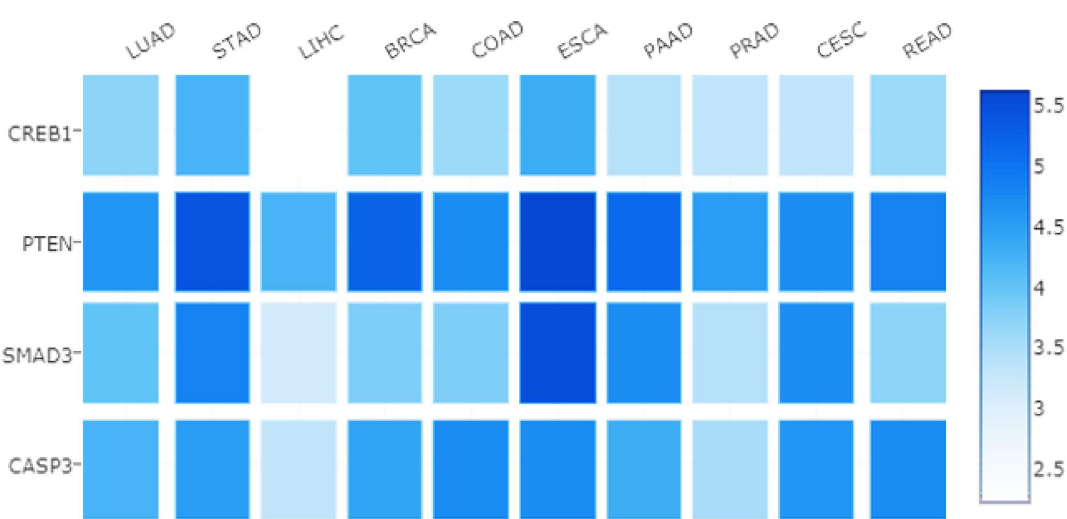
Figure 6. A heatmap of candidate genes in the ten most fatal types of cancer. The GEPIA 2 server has provided the expression levels of candidate genes in the most fatal types of cancer. LUAD (Lung adenocarcinoma), STAD (Stomach adenocarcinoma), LIHC (Liver hepatocellular carcinoma), BRCA (Breast invasive carcinoma), COAD (Colon adenocarcinoma), ESCA (Esophageal carcinoma), PAAD (Pancreatic adenocarcinoma), PRAD (Prostate adenocarcinoma), CESC (Cervical squamous cell carcinoma), READ (Rectum